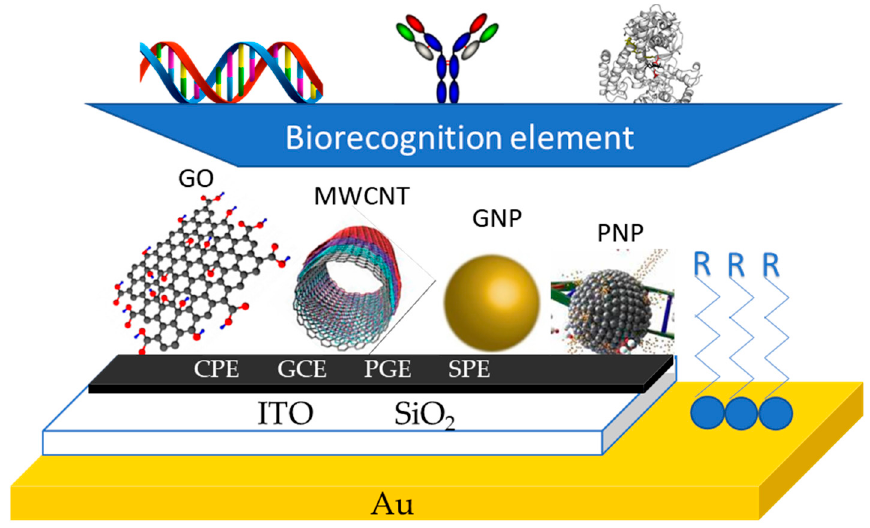
Figure 4. Schematic representation of possible compositions and treatments of layers of biosensors